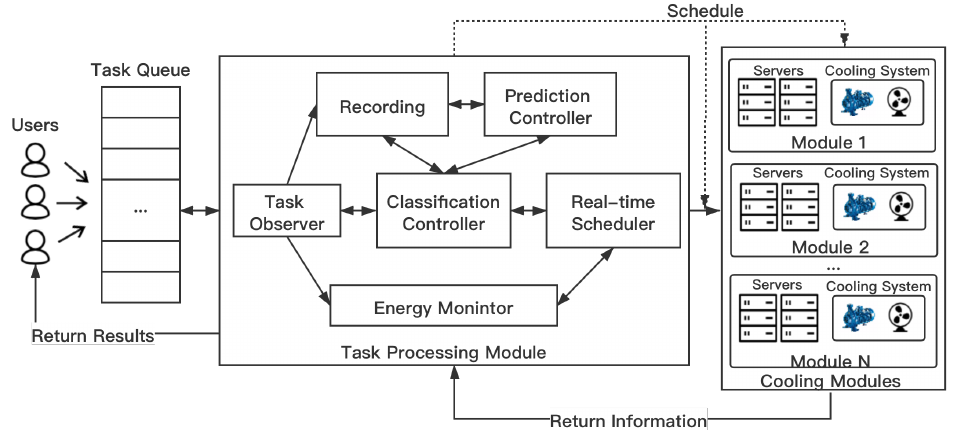
Figure 1. The structure of the data center.